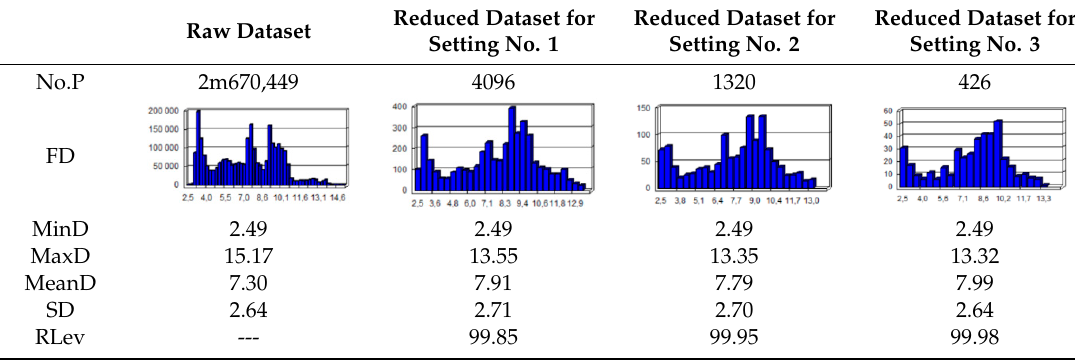
Table 2. Statistics for points reduced with the TBDRed method based on the LNG port area. Reduced Dataset for Raw Dataset Setting No. 1